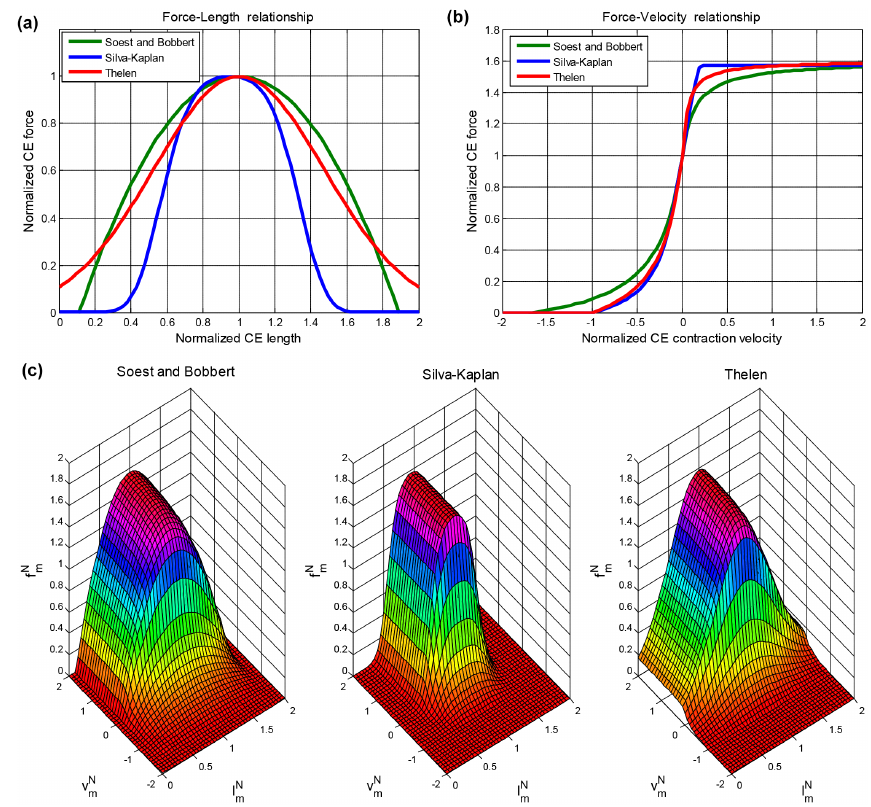
Figure 4. Comparison of the different formulations. (a) Force–length relationship. (b) Force–velocity relationship. Green solid line: Van Soest and Bobbert. Blue solid line: Kaplan–Silva. Red solid line: Thelen (c) Surface plots of the force–length–velocity relationship for the different formulations in the CE (Van Soest and Bobbert, Kaplan–Silva and Thelen, respectively.